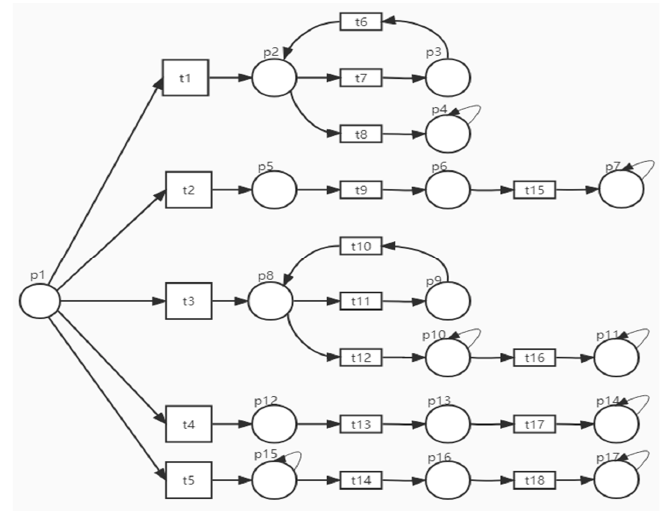
Figure 6. Integrated energy system Petri network model for transportation industry. The place represents the subsystems in the energy system, and the variation means the transitions between different systems. The role of the change is to change the place from one state to another by implementing the change. The prominent locations of the Petri network repositories of the transitions energy system and their descriptions are shown in Table 2. Table 2. Main locations and their descriptions.